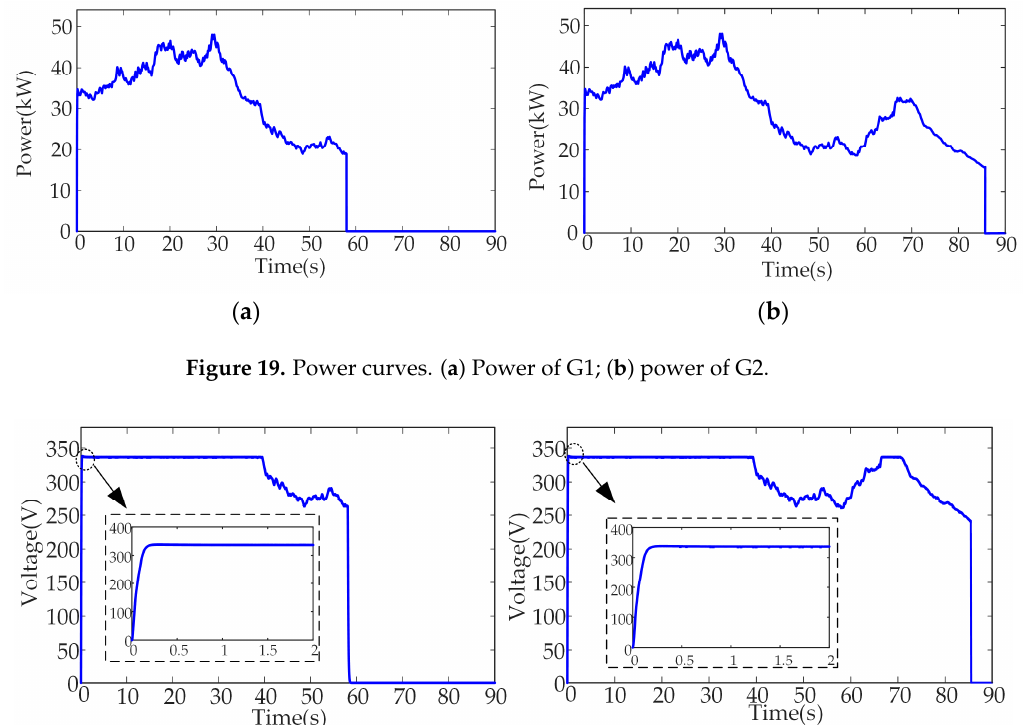
Figure 18. DC bus voltage under irregular incident waves.